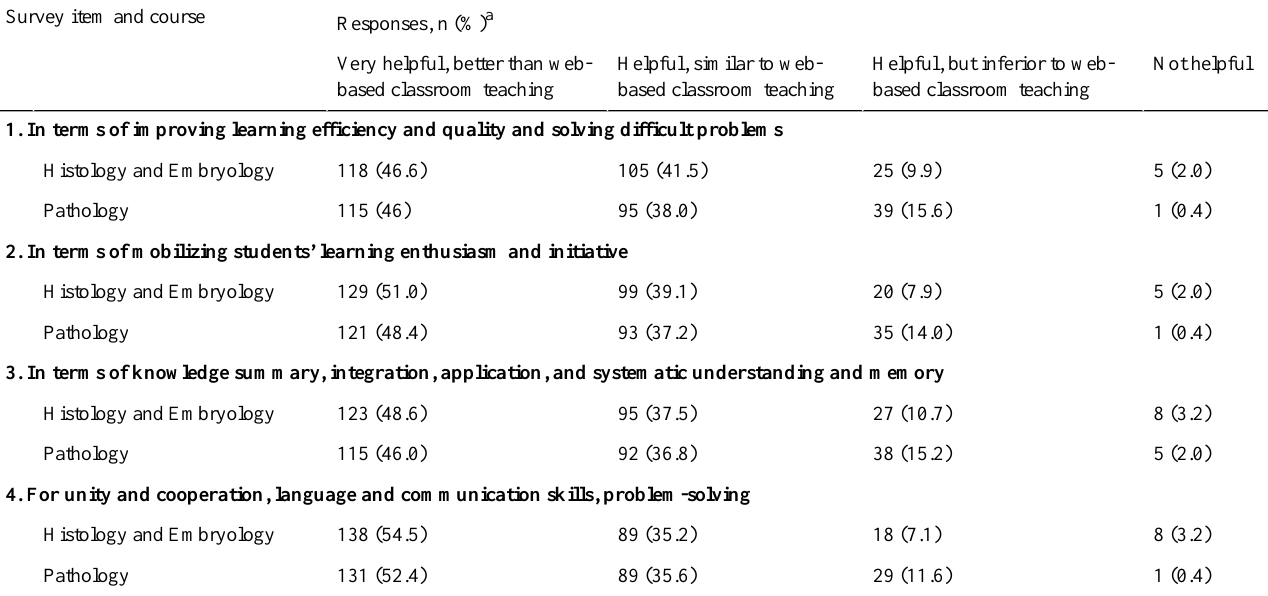
Table 3. Results of the survey questionnaire showing the students’satisfaction with the offline teaching performance in the control group.